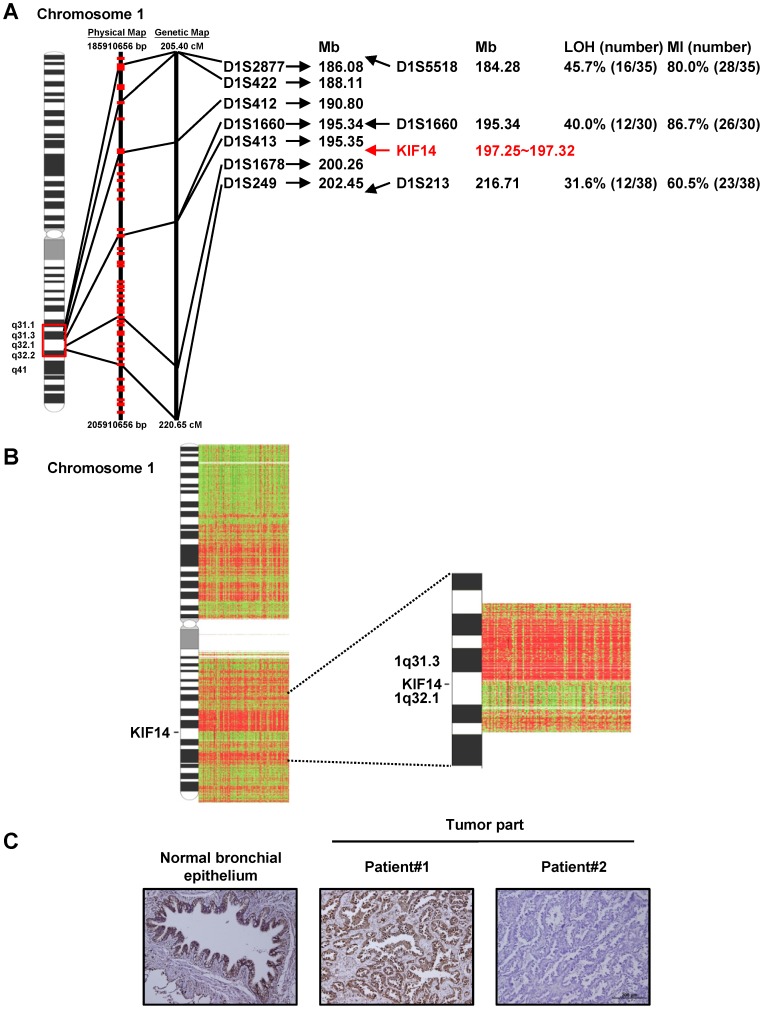
The down-regulation of KIF14 occurred in lung adenocarcinomas.(A) Loss of heterozygosity (LOH) and microsatellite instability (MI) analyses near the location of KIF14 in primary lung adenocarcinoma. Chromosome 1 ideogram showing the microsatellite markers mapped on 1q according to the location database; the patient number and percentage are indicated. (B) The copy-number alteration profiles of chromosome 1. The KIF14 location is indicated within chromosome 1q32.1. (C) The protein expression pattern of KIF14 was examined using immunohistochemistry with anti-KIF14 antibodies in normal bronchial mucosa (left panel) and primary tumor specimens (middle and right panel). Original magnification 200×.